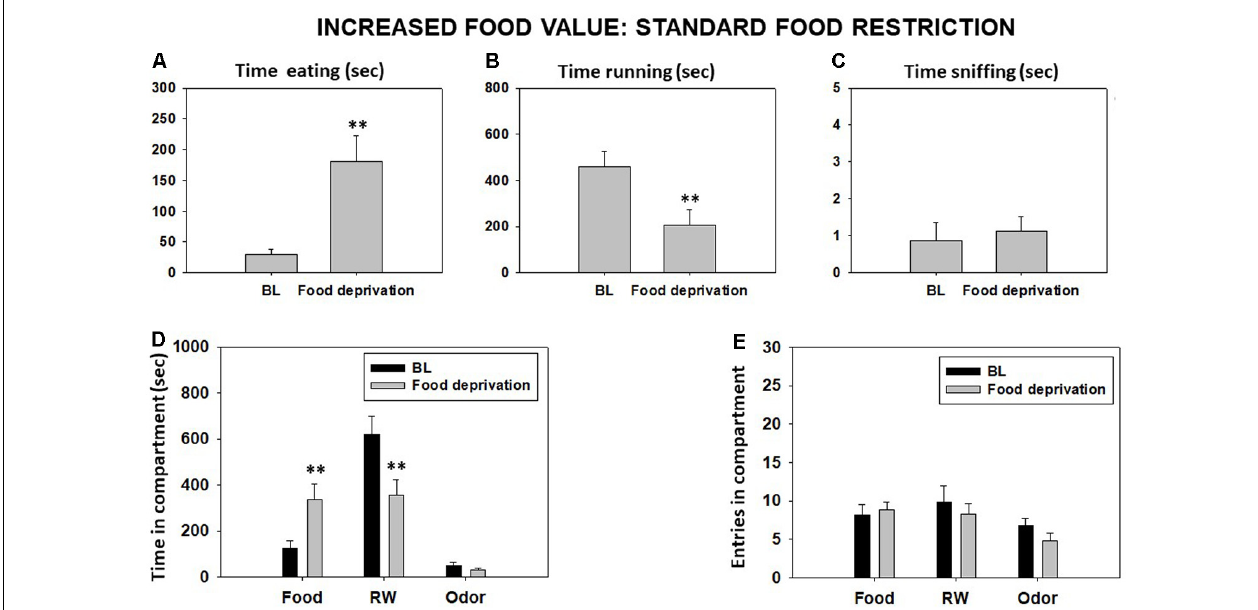
FIGURE 3 | Effect of home food restriction in mice behavior in the T-maze task. Bars represent mean ( ± SEM) of time (seconds) spent eating (A) , running (B) , and sniffing the neutral odor (C) and time in different compartments (D) and entries (E) during a 15-min session. Bars represent mean ± SEM of accumulated seconds or number of entries. ∗∗ p < 0.01 significantly different from baseline